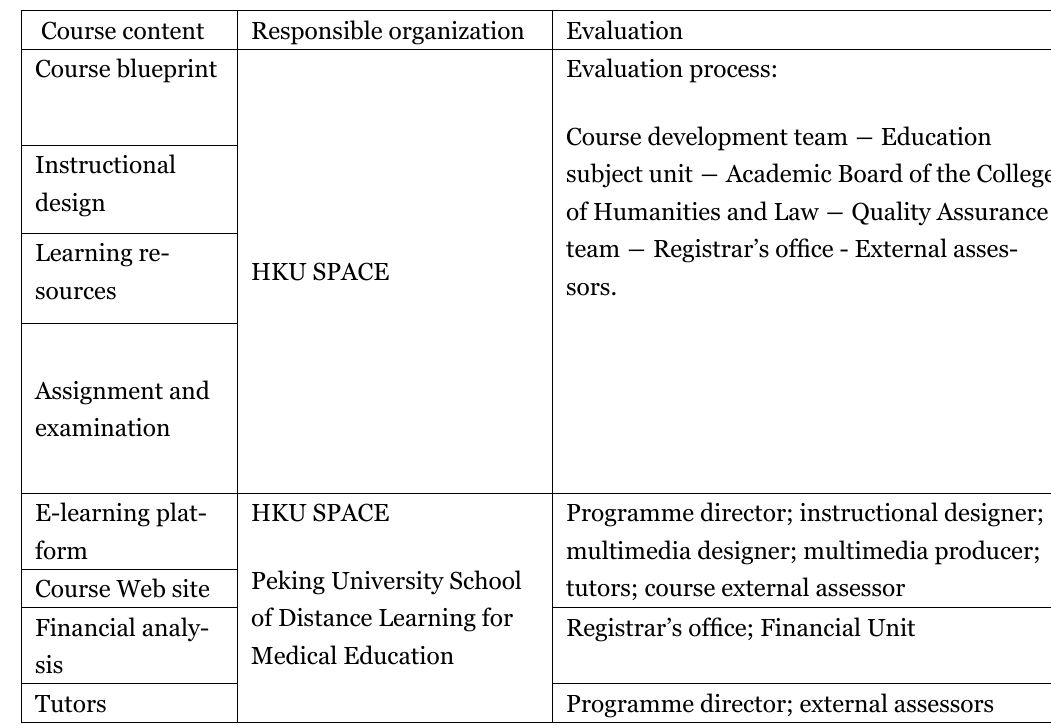
E-Learning Course Development and